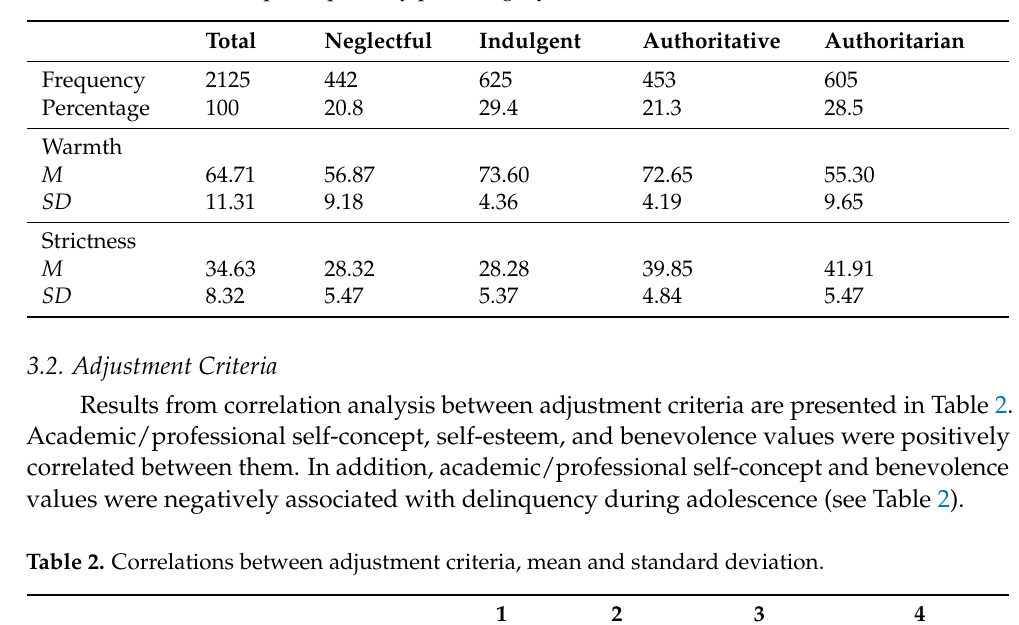
Table 1. Distribution of participants by parenting style.